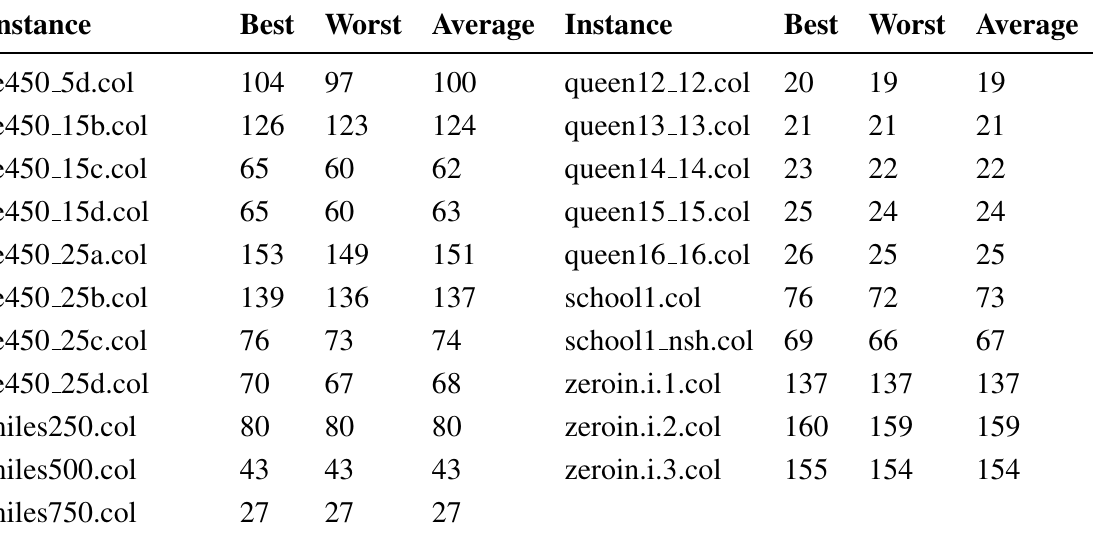
= 1 and a CPU-time max